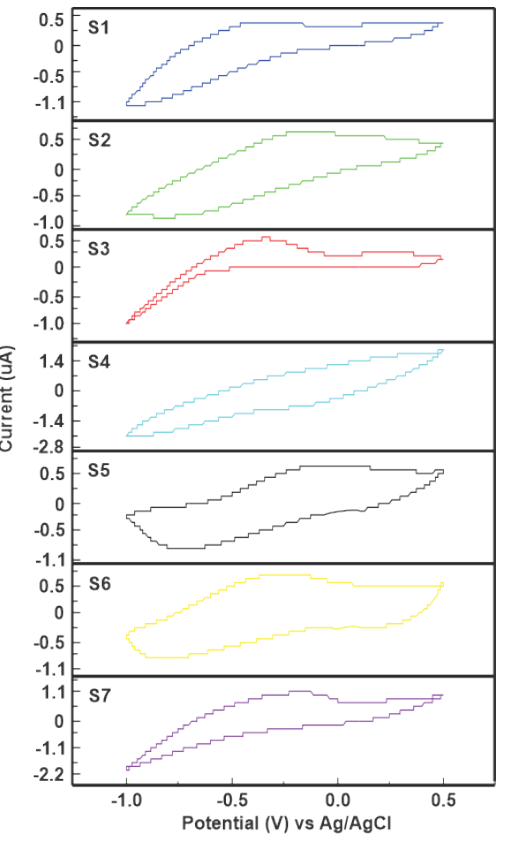
Figure 3. Voltammetric signals from the smart electronic tongue sensor array recorded in the drinking water sample M1 (C1S3- H2014).